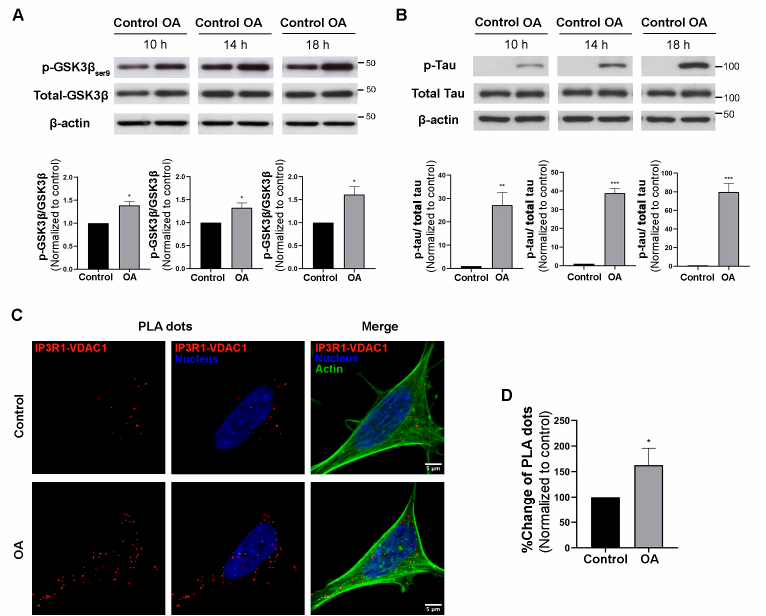
Figure 1. Effects of PP2A inhibition on pGSK3 β , pTau, and MAMs in SH-SY5Y cells. Western blot analysis of ( A ) pGSK3 β /total GSK3 β expression and ( B ) pTau/total Tau expression in control cells and okadaic acid-treated cells at 10 h, 14 h, and 18 h. The bar graphs show quantifications of the blots normalized with b-actin. ( C ) Interactions between IP3R1 and VDAC1 (PLA dots) in okadaic acid-treated cells (10 h) compared to untreated cells. Representative images showing maximum-intensity projections of confocal image stacks. ( D ) Bar graph showing quantification of PLA signals in okadaic acid-treated cells compared to untreated cells. Data represent means ± SEMs of three independent experiments. * p < 0.05, ** p < 0.01, *** p < 0.001 (Student’s t -test). Scale bars are 5 μ m.